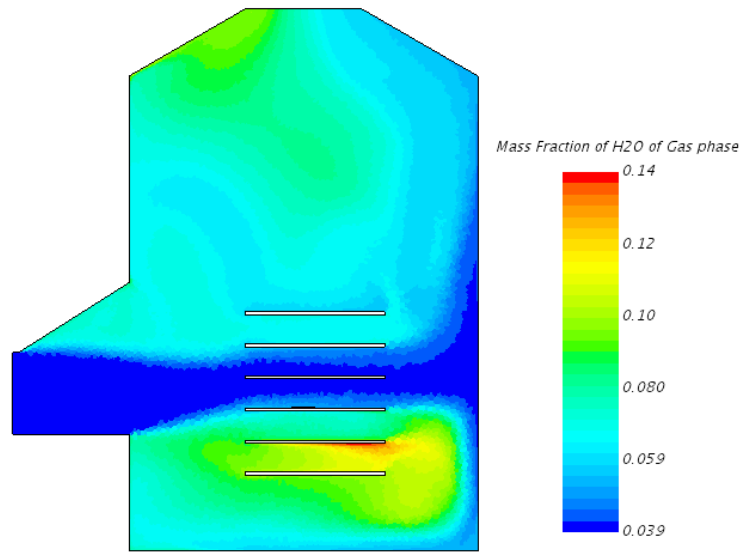
Figure 11. Mass fraction of water vapour distribution.